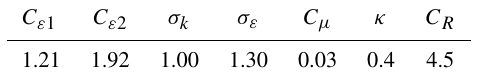
Table 1. Model constants for the k – ε – f P model as recommended by Sørensen (1995) and van der Laan (2014). Referred to later as “ABL coefs”. C ε 1 C ε